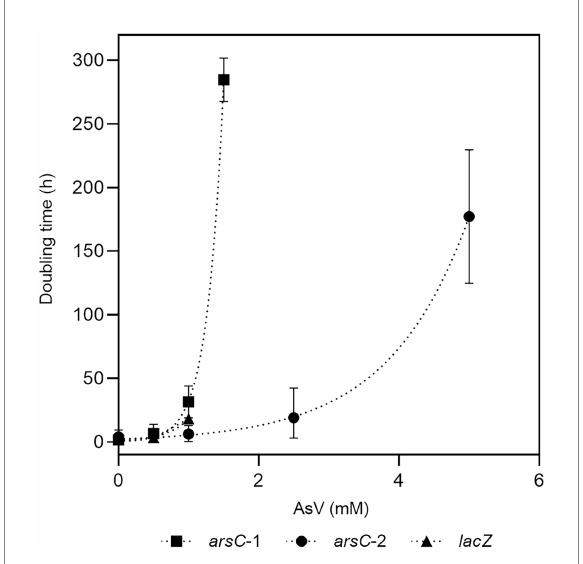
FIGURE 6 Evaluation of resistance to As(V) conferred by arsC -1 and arsC -2 from Fas . Growth of E. coli WC3110 Δ arsC strain complemented by arsC -1 Fas SHT, arsC -2 Fas SHT or lacZ genes in presence of